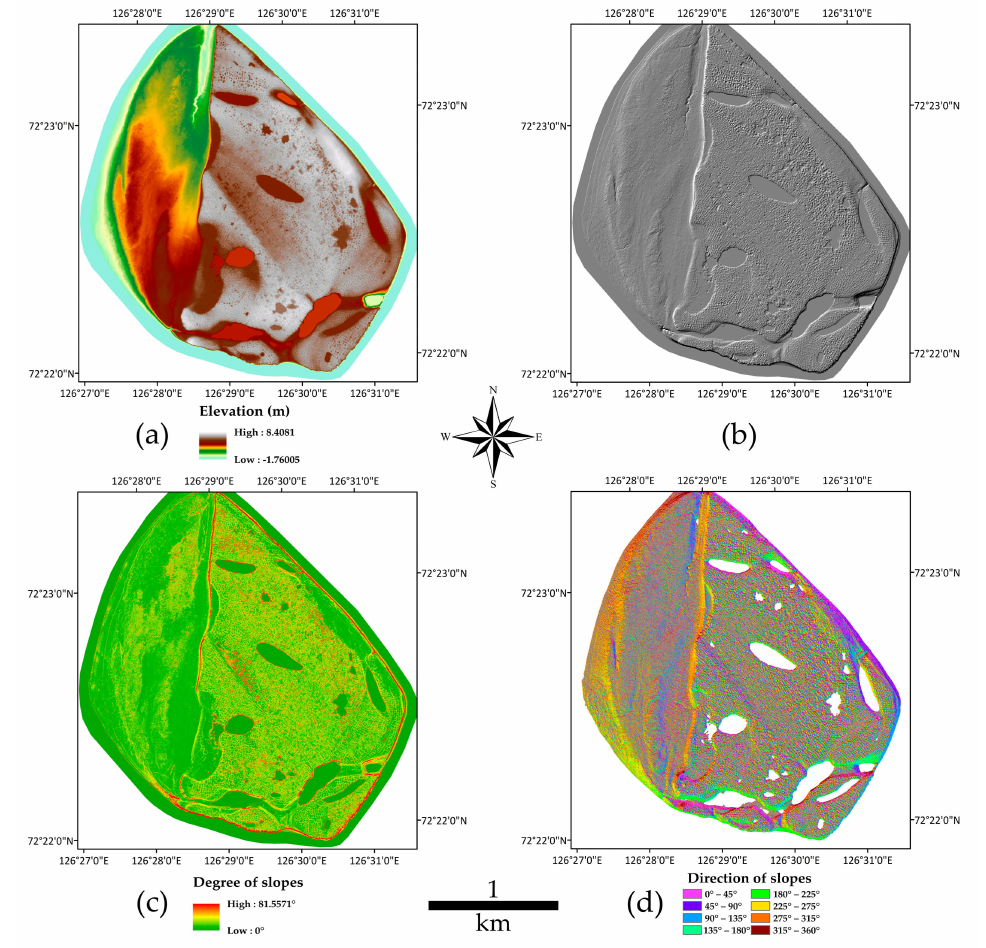
Figure 2. The obtained Samoylov Island digital terrain model ( a ) and maps of land morphometry parameters: ( b ) a shaded relief map, ( c ) a slope map, and ( d ) an aspect